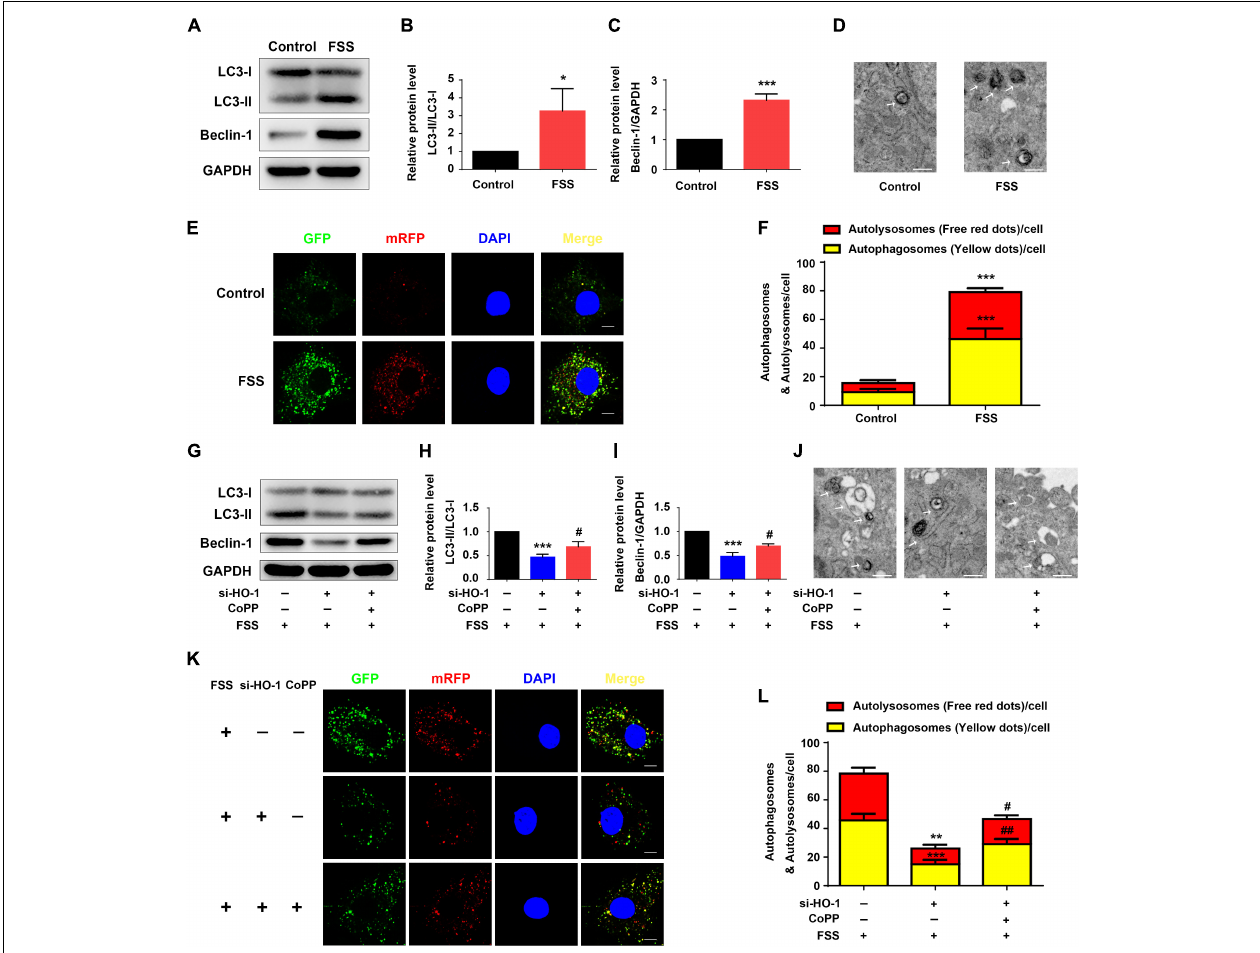
FIGURE 3 | HO-1 mediates FSS-induced autophagy in NP cells. (A–C) Western blotting. NP cells were treated with or without 12 dyne/cm 2 FSS for 2 h, followed by western blotting for expression of the indicated proteins. Quantification of LC3-II/LC3-I ratio (B) and Beclin-1 (C) . (D) Transmission Electron Microscopy (TEM). NP cells were treated as in panel (A) . TEM images are shown. Arrows indicate double-membrane autophagosomes and autolysosomes at various stages. Bar, 500 nm. (E,F) Measurements of autophagosomes and autolysosomes. NP cells were infected with lentivirus expressing a tandem mRFP-GFP-LC3 construct and treated with or without 12 dyne/cm 2 FSS for 2 h. Fluorescence images were obtained. Bar, 5 µ m. Quantification of autophagosomes (yellow dots) and autolysosomes (free red dots) (F) . (G–I) Western blotting. NP cells were first treated with and without HO-1 siRNA knockdown and in the presence and absence of CoPP. Then, cells were pretreated with or without HO-1 inducer cobalt protoporphyrin IX (CoPP) (10 µ M) and subjected to 12 dyne/cm 2 FSS for 2 h, followed by western blotting for expression of the indicated proteins. Quantification of LC3-II/LC3-I ratio and Beclin-1 from three independent experiments (H,I) . (J) TEM. NP cells were treated as in panel (G) . TEM images are shown. The arrows indicate double-membrane autophagosomes and autolysosomes. Bar, 500 nm. (K,L) Measurements of autophagosomes and autolysosomes. NP cells were transduced with lentivirus expressing a tandem mRFP-GFP-LC3 construct and treated as in panel (G) . Fluorescence images were obtained. Bar, 5 µ m. Quantification of autophagosomes (yellow dots) and autolysosomes (free red dots) from three independent experiments (L) . * P < 0.05, ** P < 0.01, and *** P < 0.001 vs. control; # P < 0.05 and ## P < 0.01 vs. FSS + HO-1-siRNA